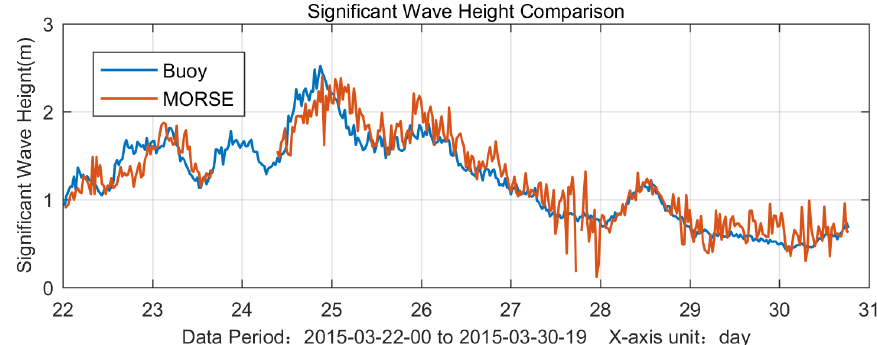
Figure 12. Significant wave height measured by MORSE and the